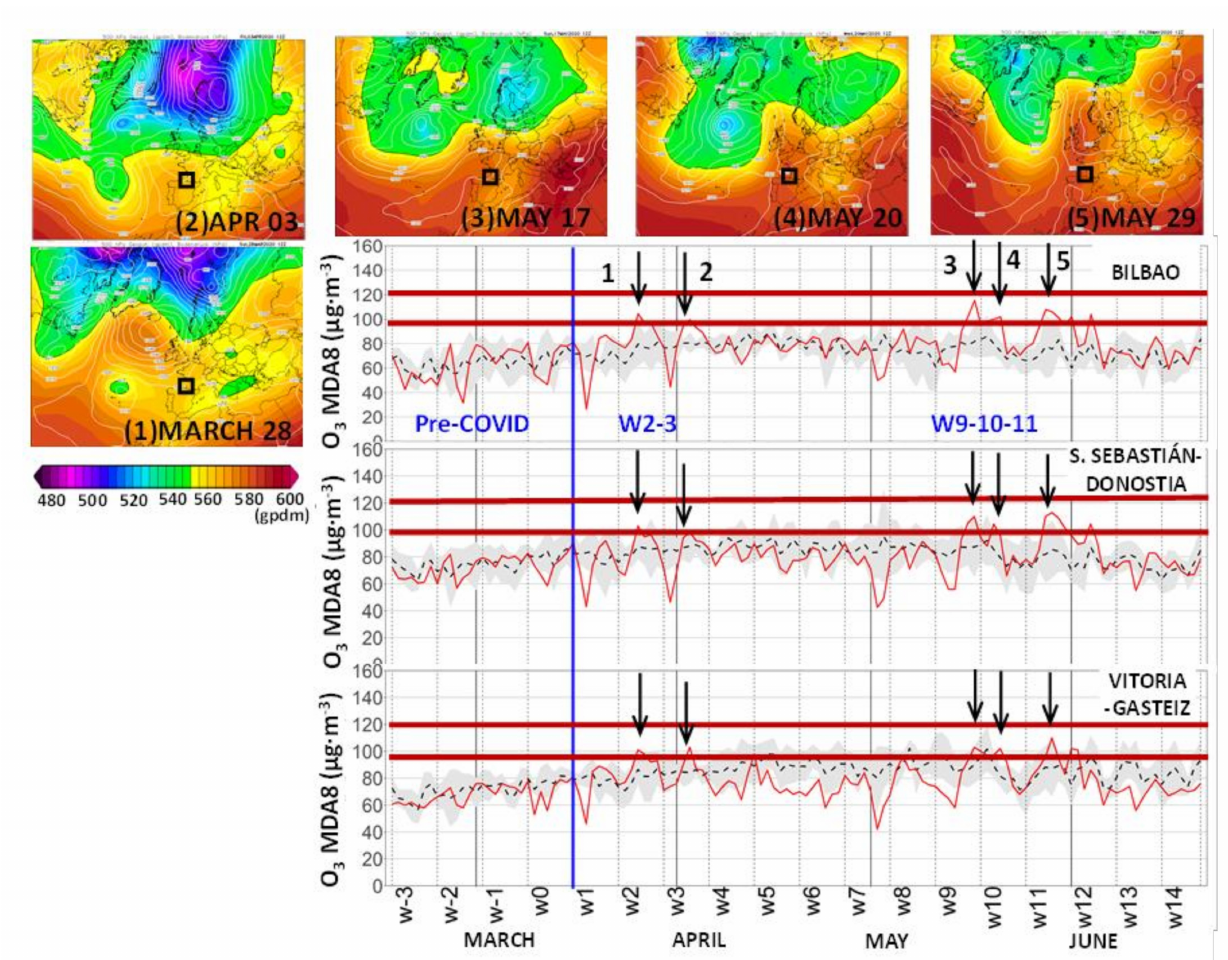
Figure 7. MDA8 ozone daily series during a pre − COVID19 four-week period and the lockdown period (solid red line) in the three urban sites. The series is represented in Figure 4c,d for NO 2 . Inter-annual averages (dashed) with their standard deviation (gray shading) can be compared with the lockdown daily values (solid red). Five simultaneous O 3 exceedances of the WHOAQG of 100 µ g · m − 3 (horizontal red line) are marked (arrows) during weeks 2, 3, 9, 10, and 11 of the lockdown period. The synoptic forcings of the respective episodes are shown (upper panels) in the Climate Forecast System Re-analysis (CFSR), one panel per episode: the 500 hPa geopotential heights (gpdams) and mean sea level pressure (MSLP) contours (hPa) at 12:00 UTC are depicted (Source: